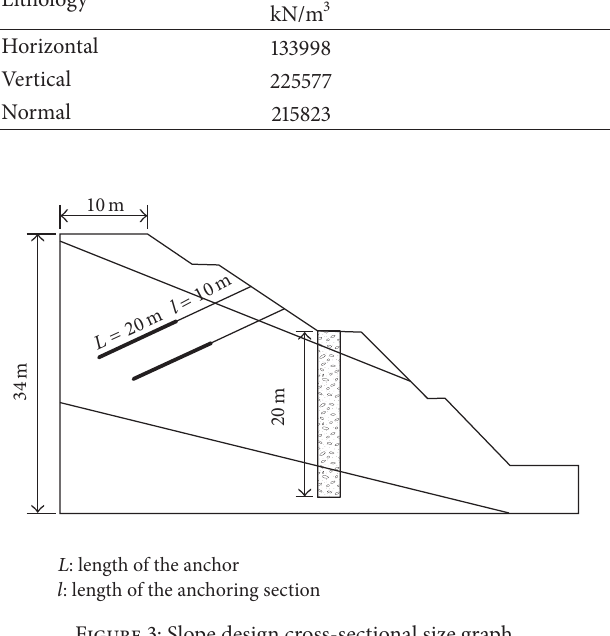
Figure 3: Slope design cross-sectional size graph.